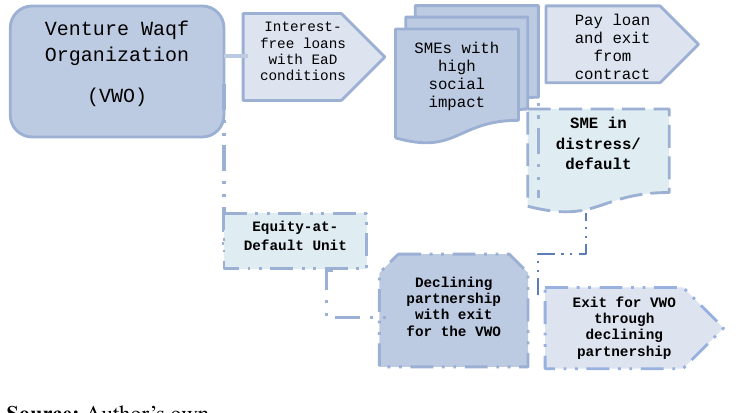
Figure 9. Baseline